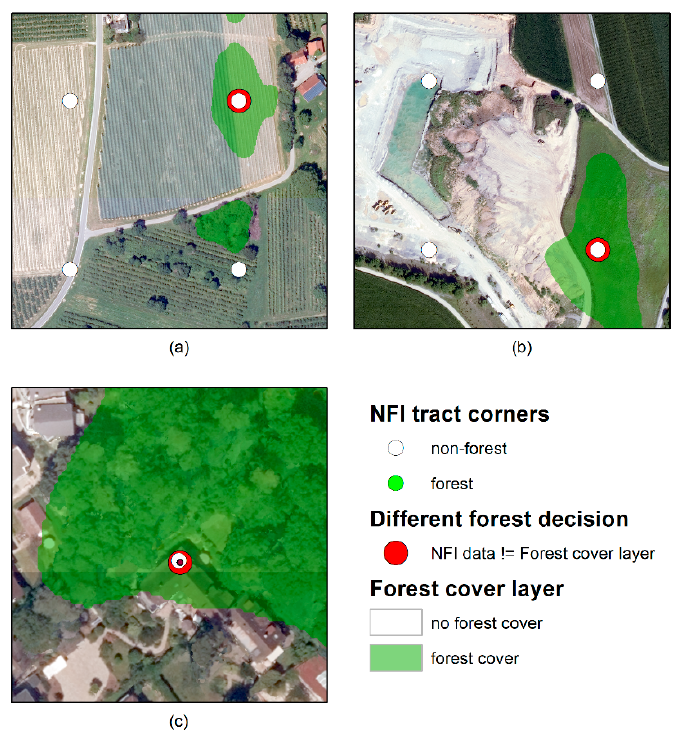
Figure 10. NFI plots with different forest decisions in the NFI plot data and forest cover layer caused by errors in the forest cover layer. ( a , b ) Differences in agricultural fields, and ( c ) NFI plot located on arooftop. Differences are outlined in red.